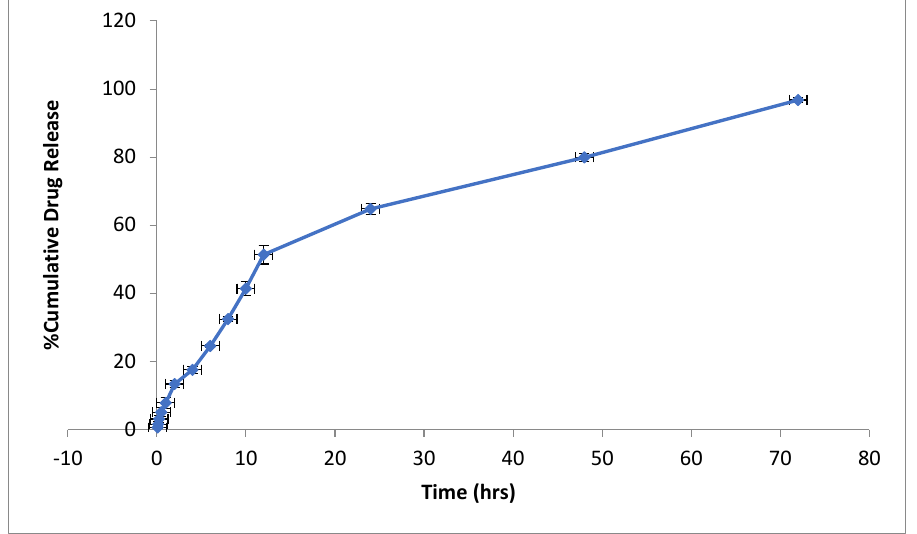
Figure 7. Graphical representation of drug release from the nanoemulsion loaded with methotrex- ate.